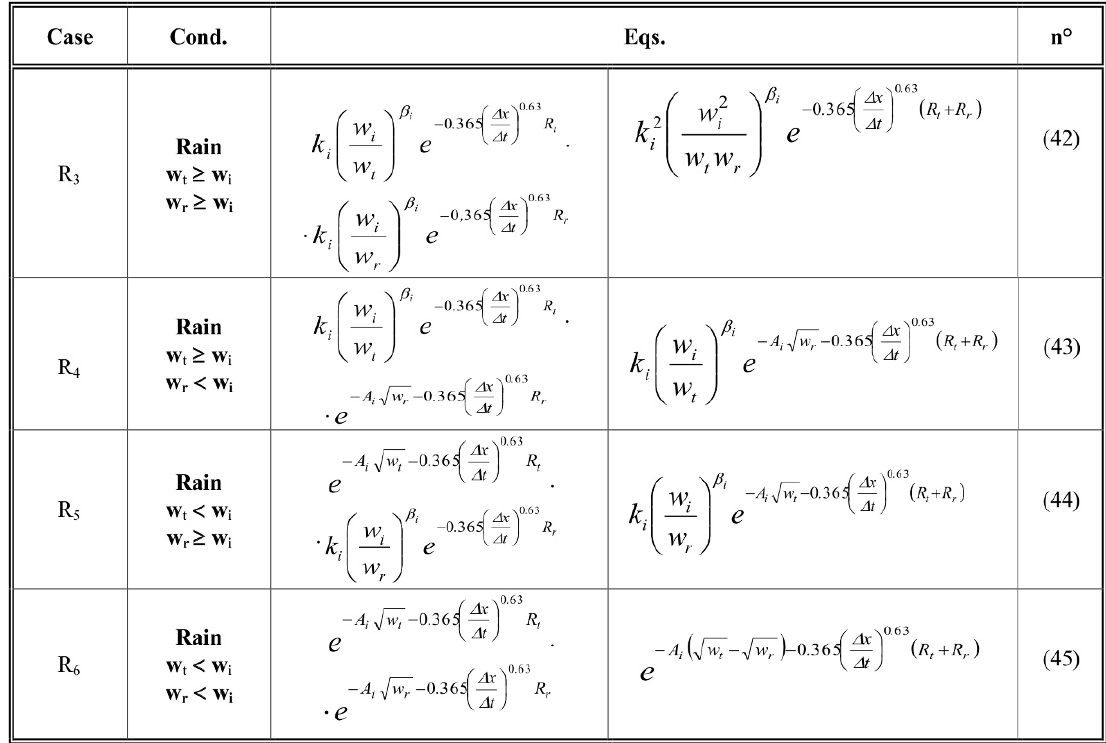
Table 9. ESLM-rain equations for transmitter and receiver not